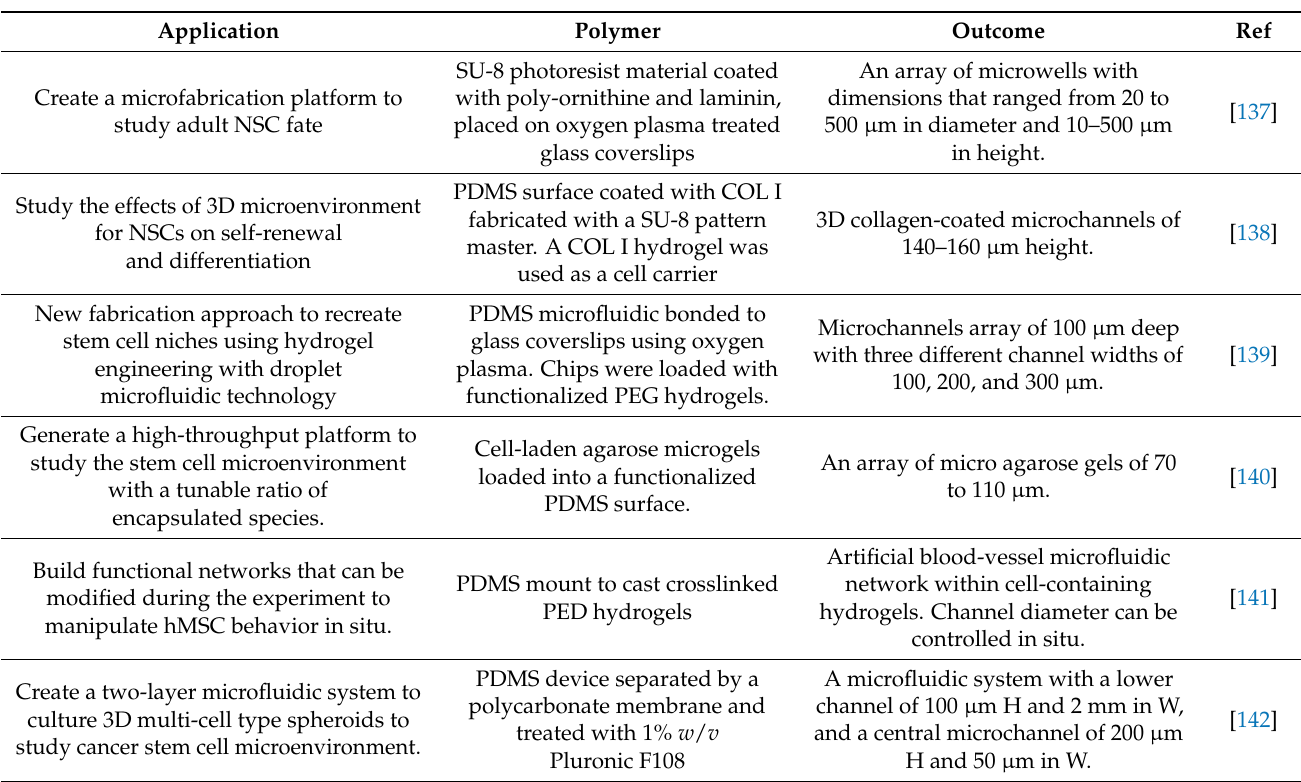
Table 4. Summary of microfluidic devices used to recreate the micro and nano spatial cues of the cell microenvironment.